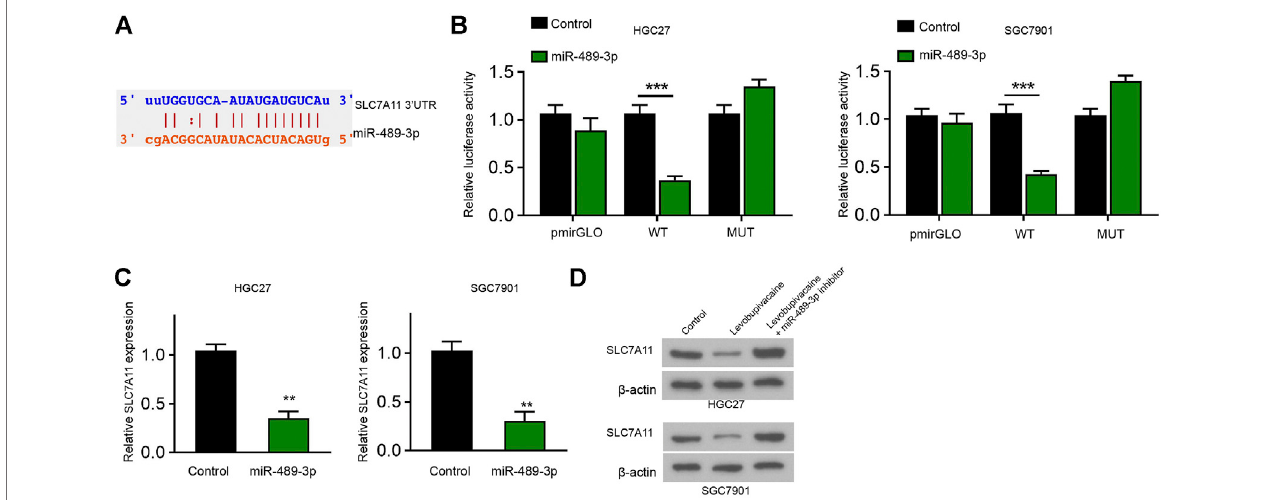
FIGURE 6 | MiR-489-3p targets ferroptosis inhibitor SLC7A11 in gastric cancer cells. (A) The binding prediction between SLC7A11 and miR-489-3p in ENCORI database. (B,C) HGC27andSGC7901cellsweretreatedwithmiR-489-3pmimic.TheluciferaseactivityofSLC7A11mRNA3 ′ UTR (B) andSLC7A11mRNAexpression (D) were detected (D) HGC27 and SGC7901 cells were co-treated with levobupivacaine and miR-489-3p inhibitor. Western blot analysis of SLC7A11 expression. The experiments were performed independently three times (mean ± SD, ** p < 0.01, *** p <